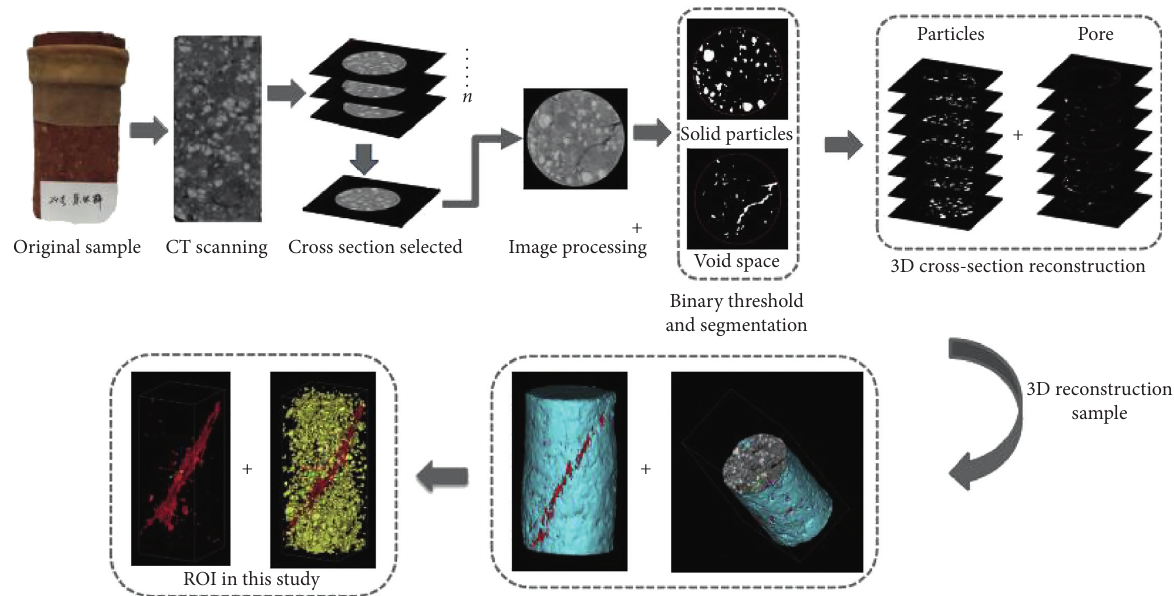
Figure 4: Illustration of image processing of this study.